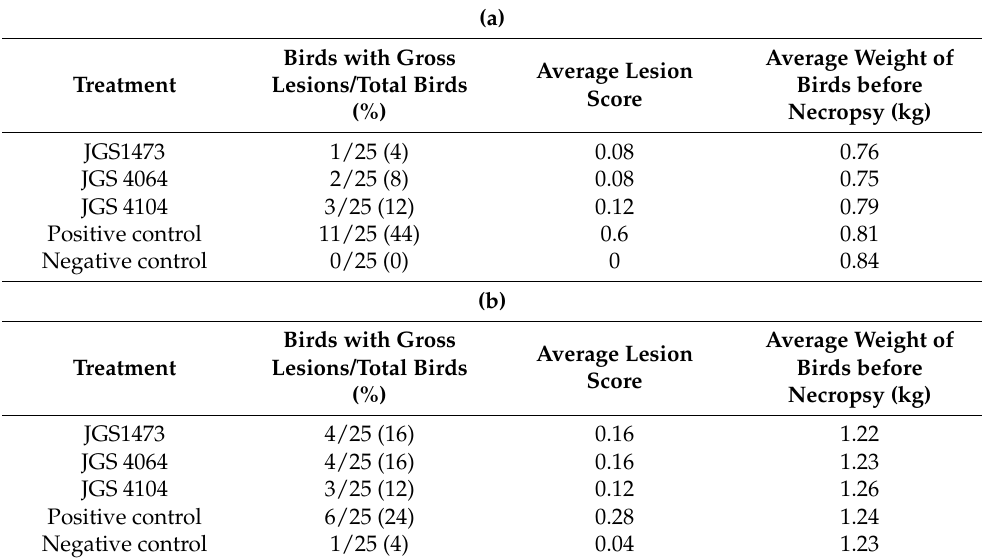
Table 2. ( a ) Response of birds to early-challenge with various C. perfringens (CP) strains. ( b ) Response of birds to late-challenge with various C. perfringens (CP)